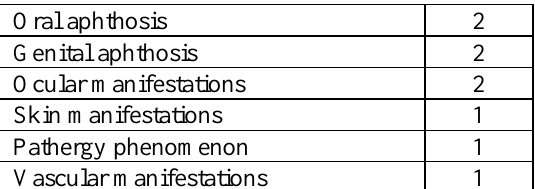
Table 1: International Study Group